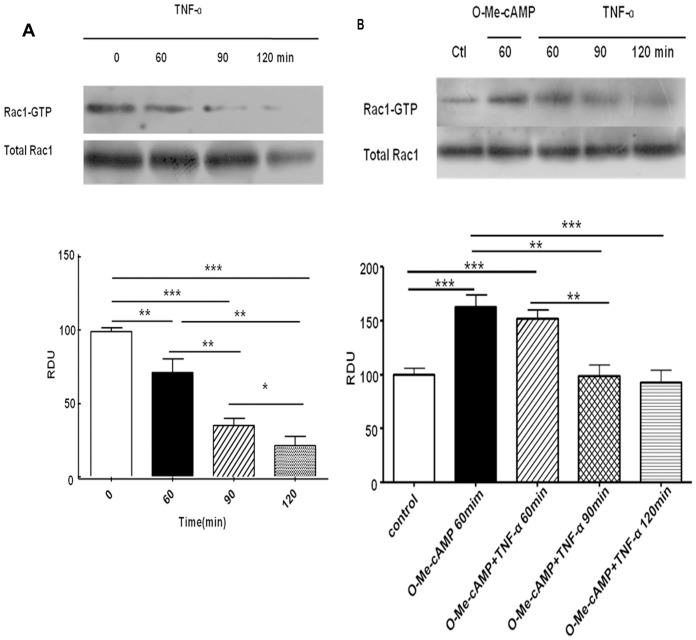
Effect of TNF-α, O-Me-cAMP or TNF-α combined with O-Me-cAMP on activity of Rac1. EC were stimulated with TNF-α(100 ng/ml) or O-Me-cAMP (200 mM) or TNF-α combined O-Me-cAMP for indicated time points. A: Effects of TNF-α on activity of Rac1 were evaluated using GTPase pulldown assays and normalized to the total GTPase content in cell lysates. After 60 minutes of TNF-α treatment, Rac 1 activity (n = 6) was significantly reduced to 71±10%, after 90 minutes, Rac1 activity was reduced to 35±5%(n = 6) and then more reduced to 21±6% (n = 6) after 120 minutes. B: O-Me-cAMP treatment alone (n = 6) resulted in significant activation of Rac1 to 163±11%. Pre-incubation of endothelial monolayer with O-Me-cAMP for 60 minutes before TNF-α treatment blocked Rac1 inactivation. Values are mean±SD. *P<0.05, **P<0.01, ***P<0.001.